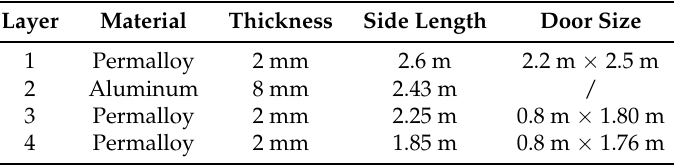
Table 1. Dimensions of each layer of the MSR.